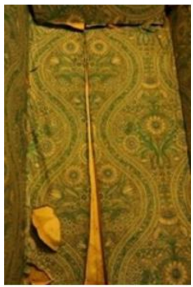
Figure 12. Indoor wall in one of the rooms